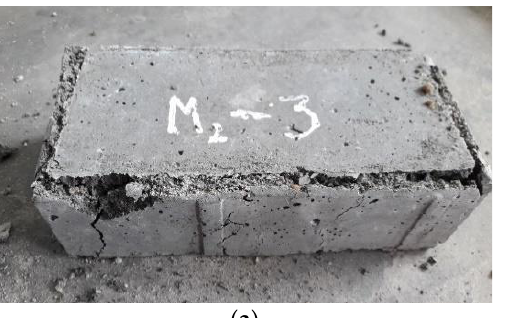
Figure 7. Failure Patterns of the IPB from Batch 1 and 2: ( a ) CR-based block; ( b ) CCF-based block.